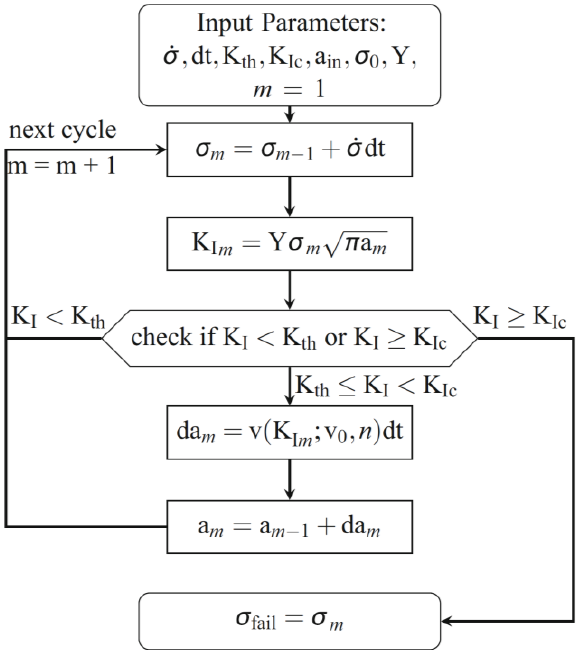
Figure 7. Flow chart of the algorithm for subcritical crack growth to failure.